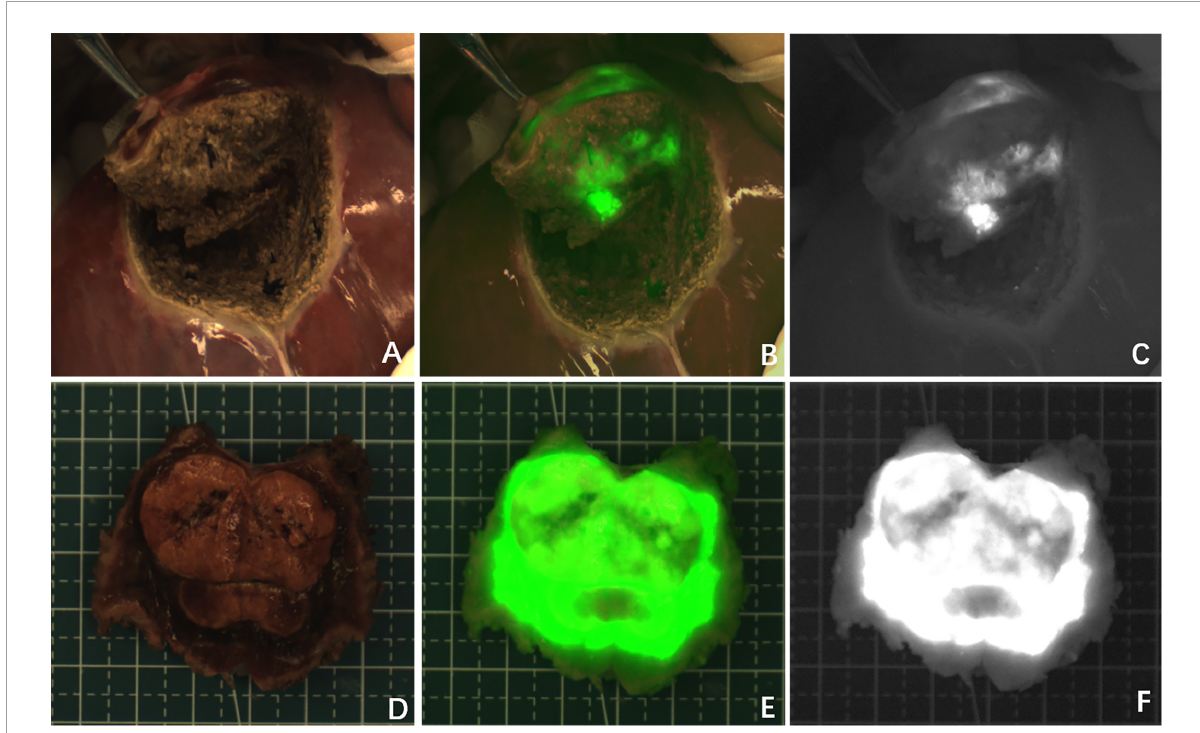
FIGURE1 Case 8. Fluorescence can be seen in almost all tumor tissue by near infrared photography in vivo (A–C) and in vitro (D–F) . The white-light image, fusion image and fluorescence image are shown in turn from left to right.